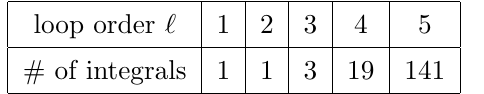
Table 1 . The number of ‘ -loop integrals I ( ‘ ) ( u; v ) contributing to the correlators (2.13). For the sake of simipicity we mode out: 1). integrals, which factorize in a product of lower-loop integrals; 2). permutations of external points; 3). rational factors in cross-ratios u; v accompanying conformal